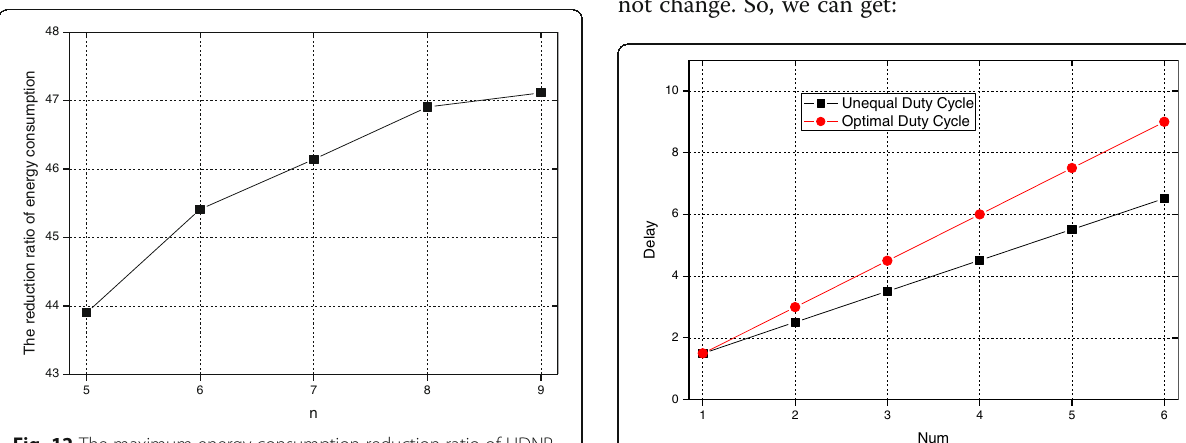
Fig. 12 The maximum energy consumption reduction ratio of UDNP